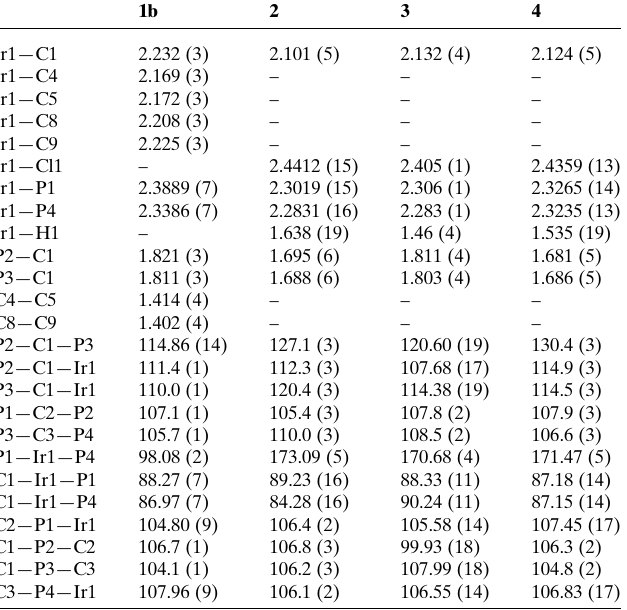
Table 1 Selected bond lengths (A˚ ) and bond angles ( (cid:3) ) for compounds 1b – 4